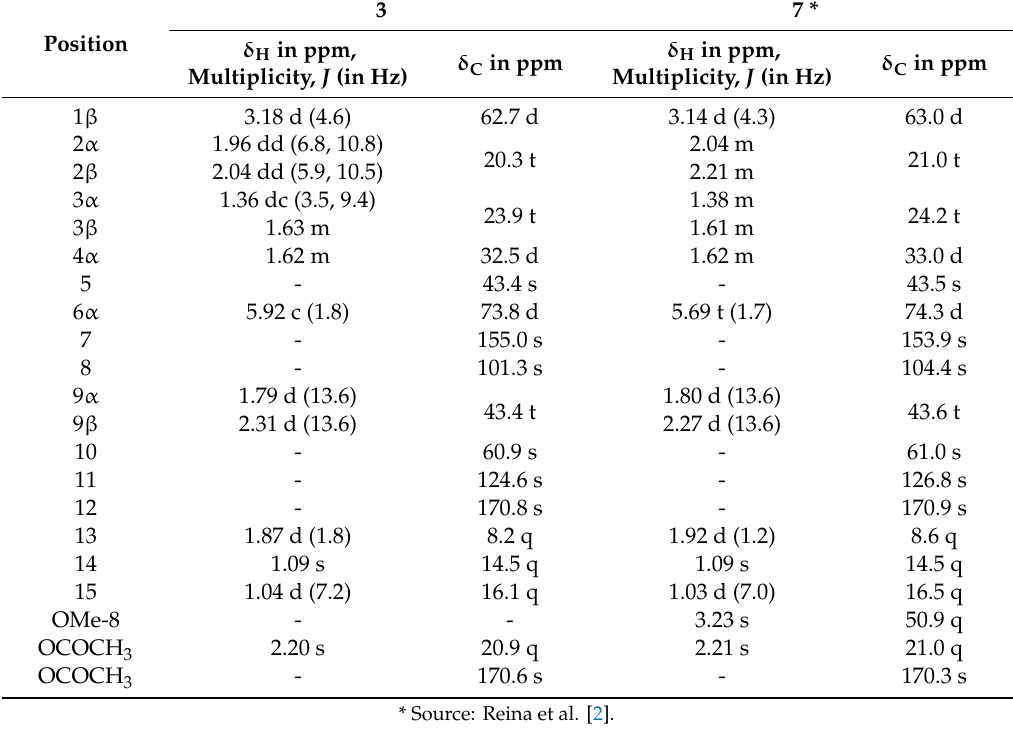
Table 2. 1 H (500 MHz) and 13 C (125 MHz) NMR data of compounds 3 and 7 * in CDCl 3 . Position